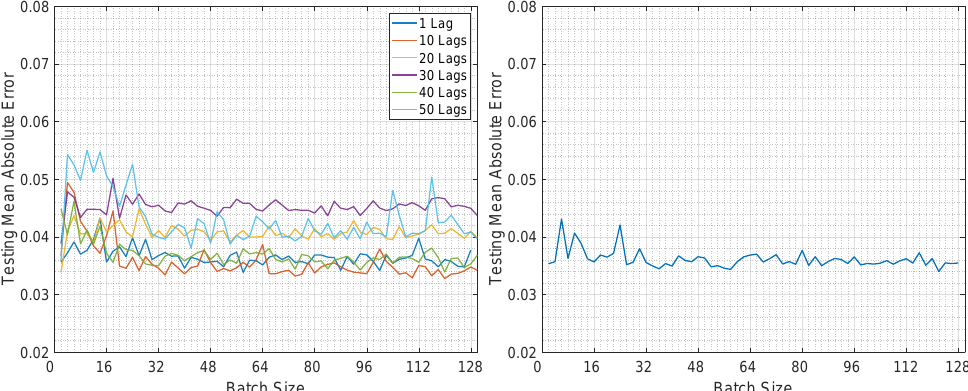
Figure 21. Illustration of the testing mean absolute error value for Experiment 2, LSTMTF ( left ) and VLSTM ( right ), using a many-to-one prediction mode. The MAE values for M2M LSTMTF were in the [0.024, 0.036] range, for M2M VLSTM in the [0.07, 0.09] range, and for M2M LSTMTFC in the [0.05, 1] range, with smaller